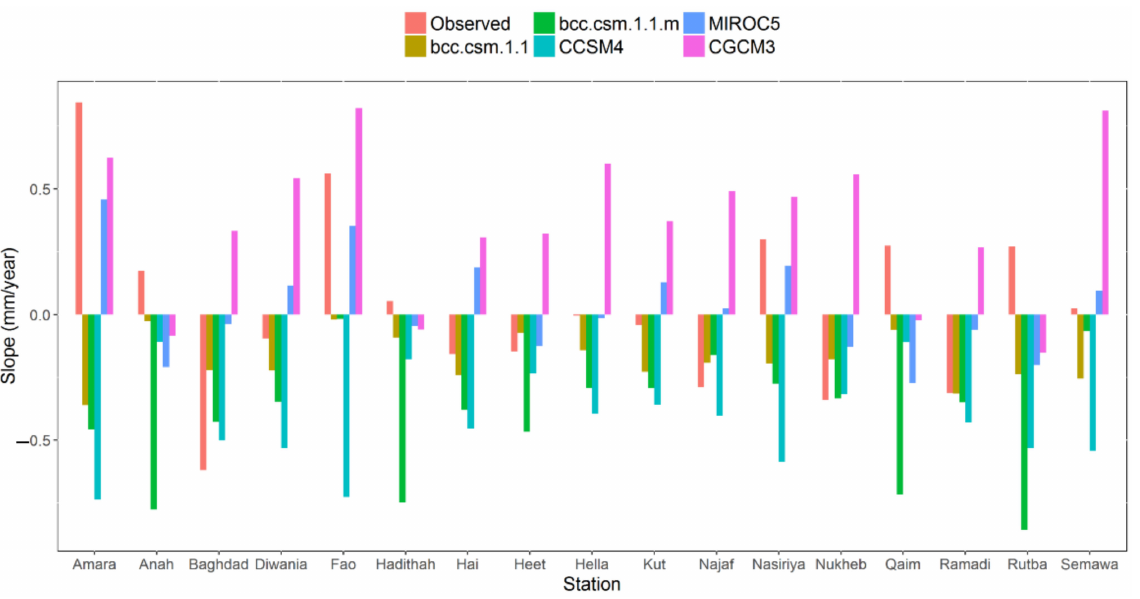
Figure 13. Linear trends of annual rainfall for the observed and simulated time series using the Mann–Kendall trend test for the median condition in zones 3 and